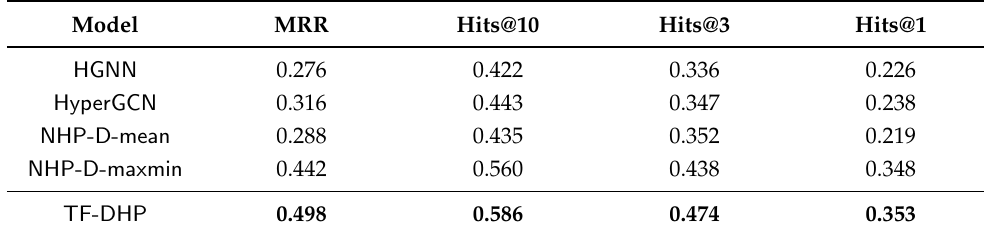
Table 6. Directed hyperlink prediction results of Reverb15K dataset. Model MRR Hits@10